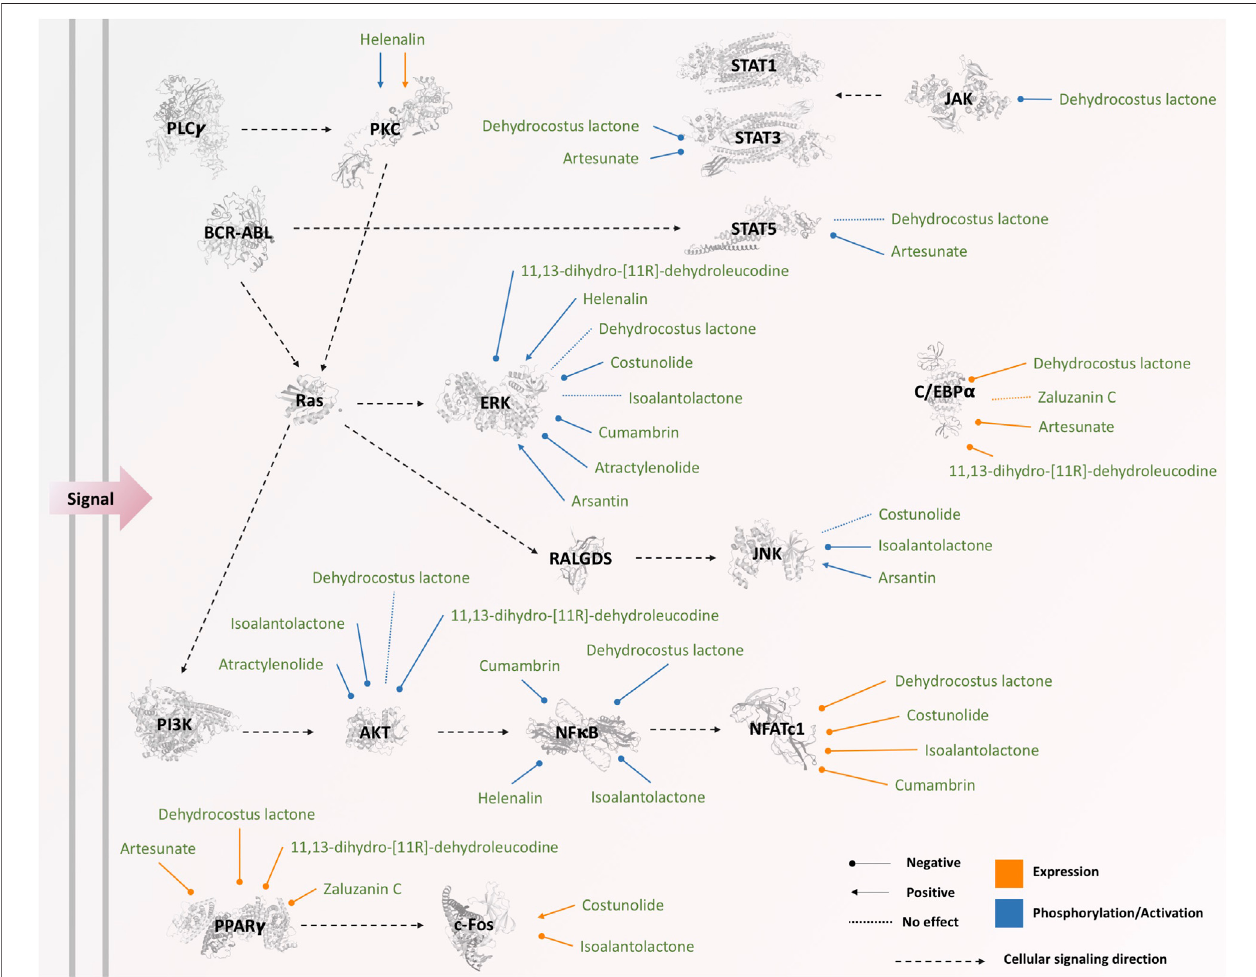
FIGURE 5 | The effects of sesquiterpene lactones on different components of signaling pathways. The phosphorylation status of JAK, BCR-ABL, ERK, PKC, STATs,PI3K,AKT,andNF κ Bwasaffectedbysesquiterpenelactones,whiletheexpressionofNFATc1,PKC,c-Fos,PPAR γ ,andC/EBP α waschangedasaresultofthe treatment. The three-dimensional illustrations of proteins were retrieved from Protein Data Bank in Europe (PDBe) hosted by EMBL-EBI (https://www.ebi.ac.uk/pdbe).